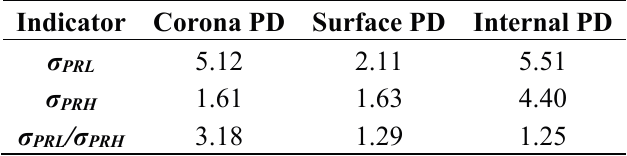
Table 3. Results obtained of the standard deviation for each cluster associated with